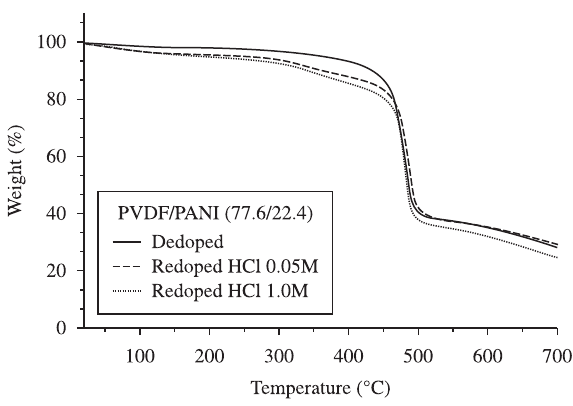
Figure 2. Thermogravimetric analysis of PVDF/PANI blends (22,4 wt. (%) PANI) dedoped and redoped with HCl 0,05 M and 1,0 M.